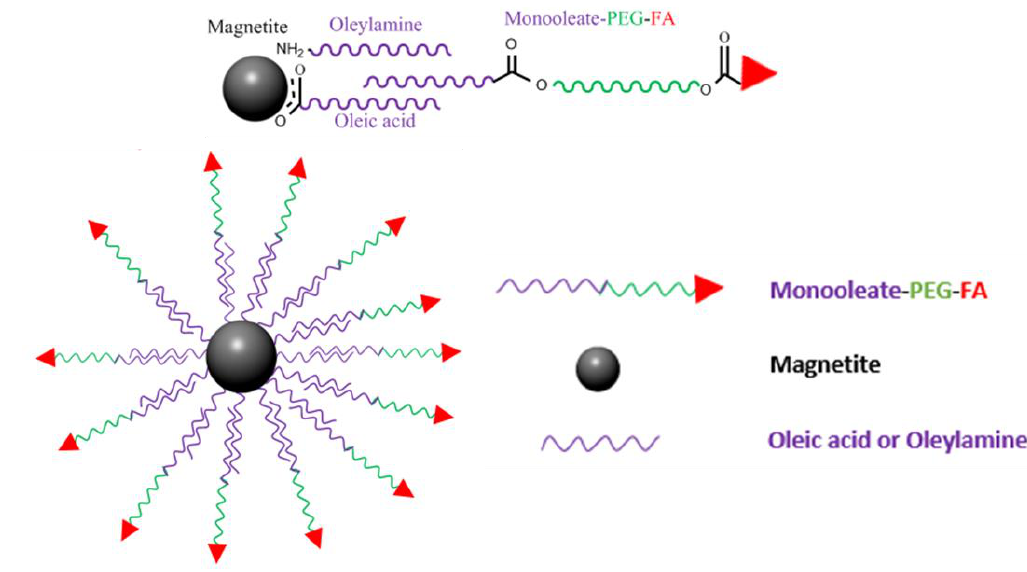
Figure 3. Magnetite-PEG-Folate nanoparticle, explaining how Folic acid (FA)-PEG-monooleate can form interdigitated bilayers to transfer hydrophobic magnetite into aqueous media, resulting in a biocompatible nanoparticulate